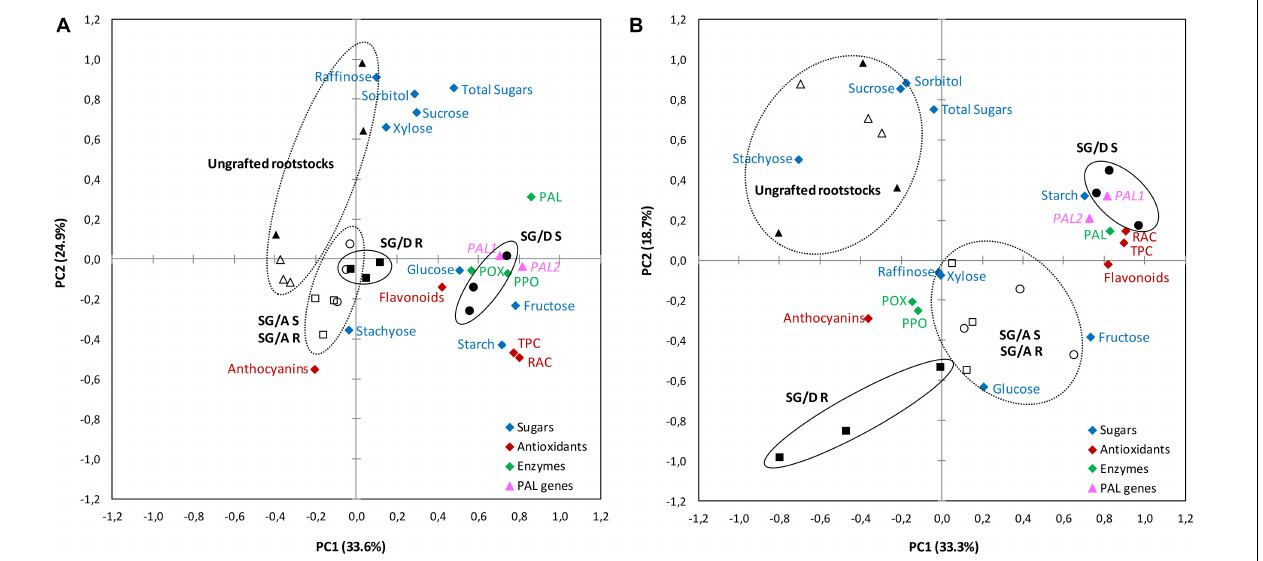
FIGURE 6 | Principal component analysis (PCA) for biochemical and molecular traits evaluated on “Summergrand” (SG) cultivar budded on “Adara” and “Damas GF 1869” rootstocks at the leaf fall (A) and vegetative (B) periods, 3 years after grafting. “SG/D” S